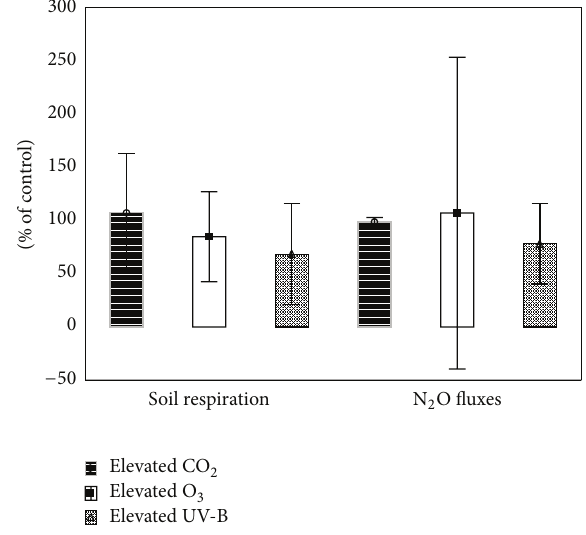
Figure 2: Effect of elevated CO 2 , O 3 , and UV-B on soil respiration and N 2 O fluxes (recalculated from [27, 34–40]). The values are expressed in % of control = 100% which represent ambient CO 2 , O 3 , or UV-B (mean ±